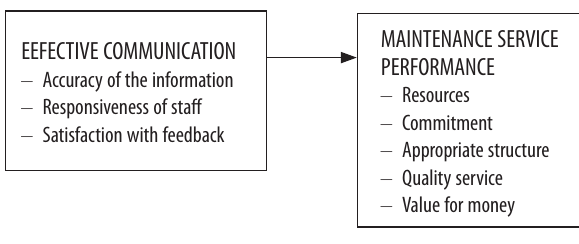
Fig. 1. Framework of